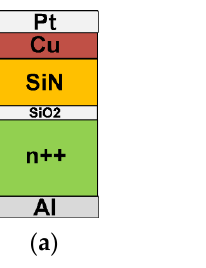
Figure 1. ( a ) Schematic representation of the fabricated and examined memristive device structure. ( b ) XTEM micro-image of the fabricated SiN x and SiO 2 layers on n ++ -Si wafer. ( b ) XTEM micro-image of the fabricated SiN x and SiO 2 layers on n ++ -Si